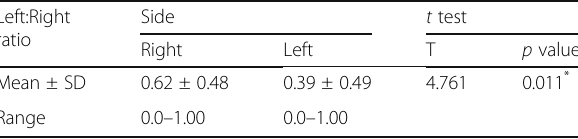
Table 11 Relation between Left to right ratio of ICWs of SPD- CAT and lesion side of stroke Left:Right Side t test ratio Right Left T p value Mean ± SD 0.62 ± 0.48 0.39 ± 0.49 4.761 0.011 * Range 0.0 – 1.00 0.0 –